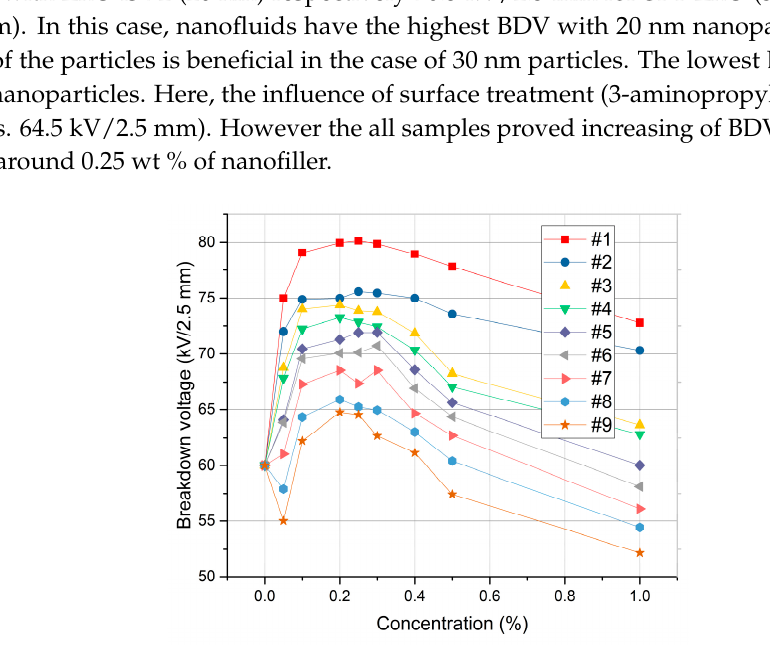
Figure 8. Breakdown voltages of nanofluids.